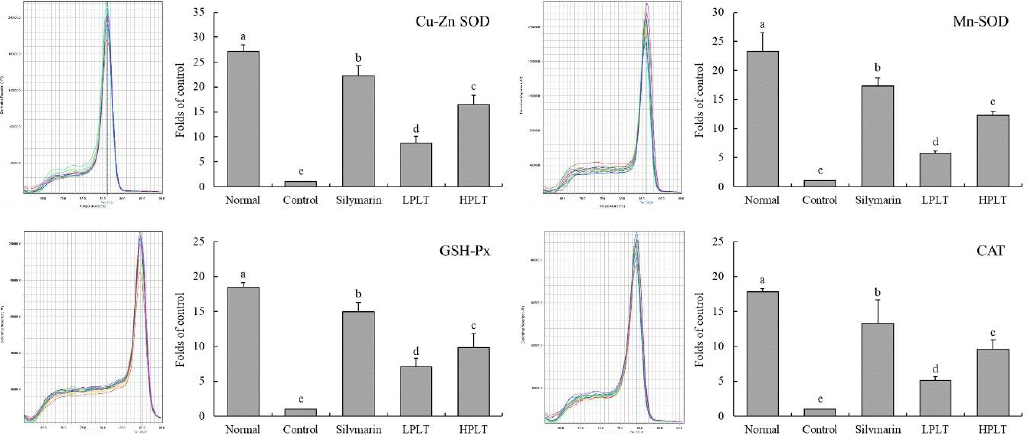
Figure 2. Cu/Zn- superoxide dismutase (SOD), Mn-SOD, glutathione peroxidase (GSH-Px), and catalase (CAT) messenger RNA (mRNA) expressions in hepatic tissue of experimental mice with CCl 4 -induced hepatic damage. Values presented are the means ± standard deviation ( N = 3/group). a – e Mean values with different letters in the same bars are significantly different ( p < 0.05) and those with the same letter in the same column are not significantly different ( p > 0.05) according to Duncan’s new multiple-range test (MRT). Silymarin group: 50 mg/kg b.w. silymarin treatment dose; LPLT group: 50 mg/kg b.w. polyphenols of Liubao tea (PLT) treatment dose; and HPLT group: 100 mg/kg b.w. polyphenols of Liubao tea (PLT) treatment dose.